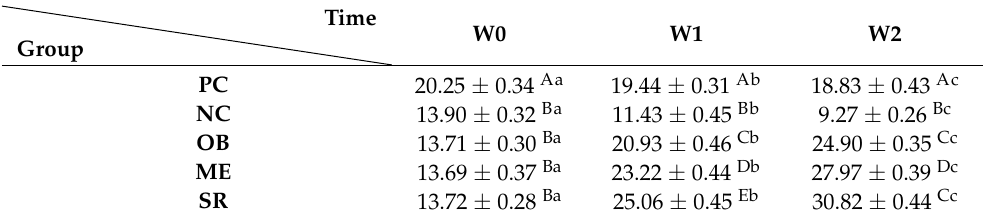
Table 4. Average collagen density (%) after each week of treatment.